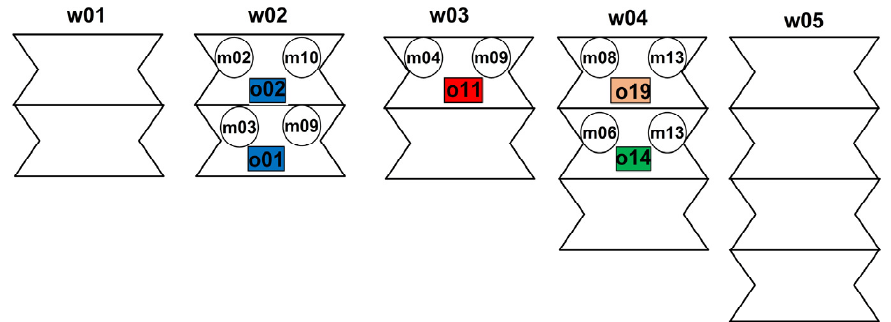
Figure 8. System configuration for a moment of time τ = 2 (concerns the question Q_4 ).